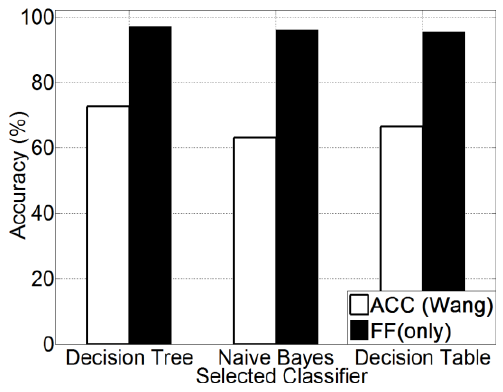
Figure 5. Human posture (and Human Powered Mobility) recognition results using different